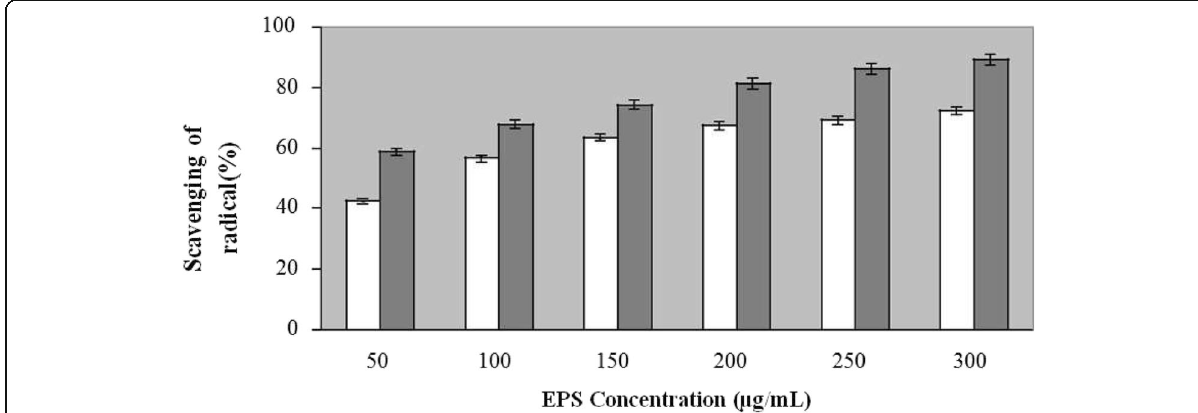
Fig. 3 Scavenging activity of ECP against superoxide radical generated in PMS/NADH system with vitamin C used as positive control. Values are means of triplicates ± SD. White bar indicates ECP, Black bar indicates Vitamin